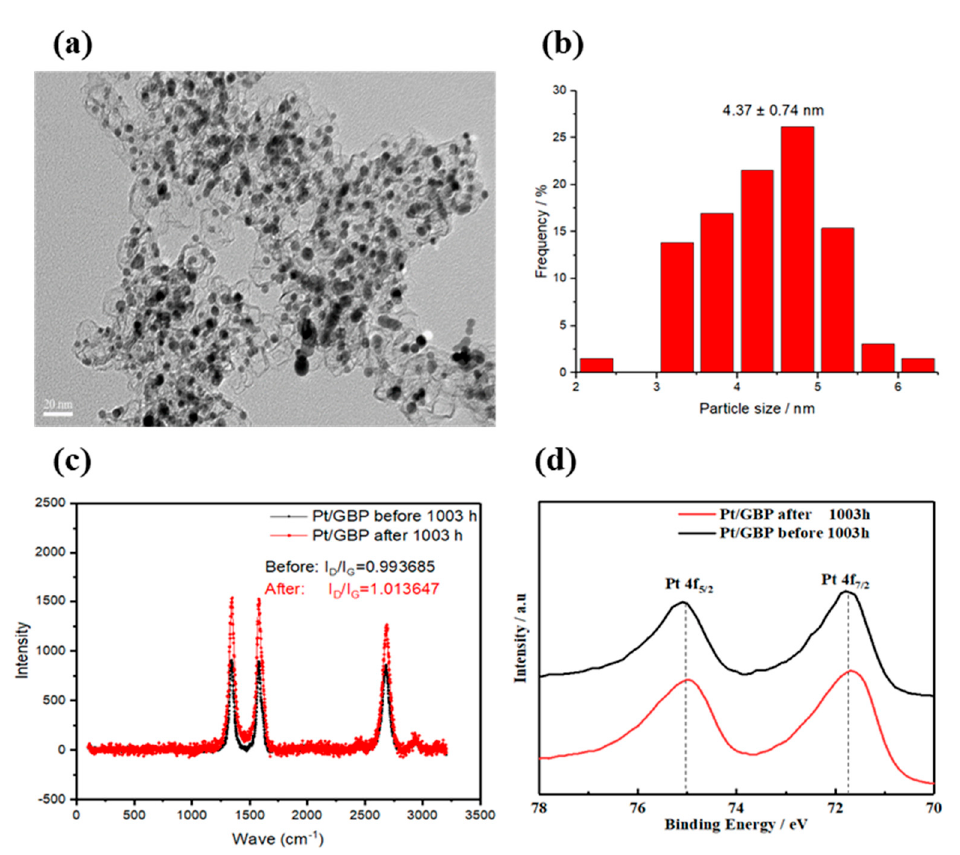
Figure 9. ( a )TEM images of the Pt/GBP catalysts in cathode after 1003 h test; ( b ) particle size distribution after durability test; ( c ) Laman and ( d ) XPS spectrum before and after durability test.